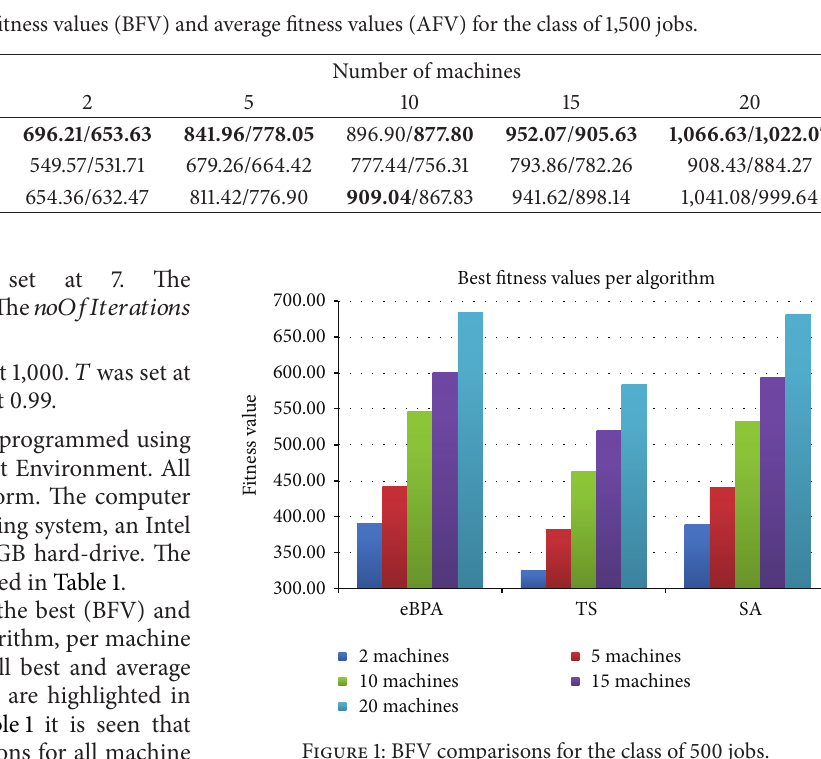
Figure 1: BFV comparisons for the class of 500